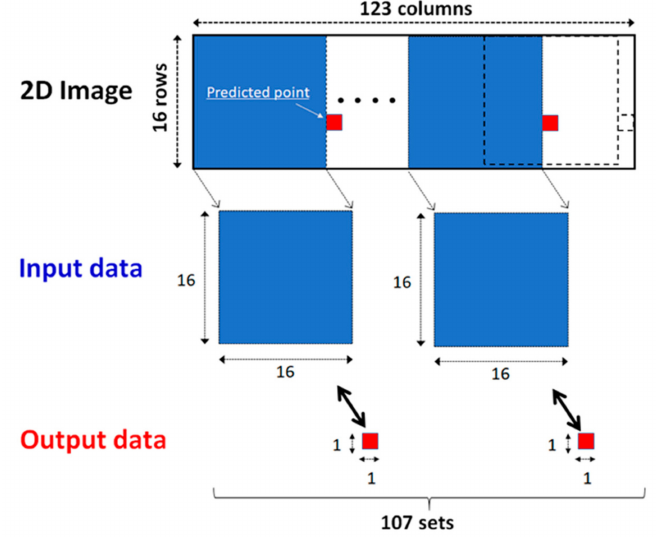
Figure 7. Sketch that shows the creation of a dataset from a 2D image to one value at the predicted